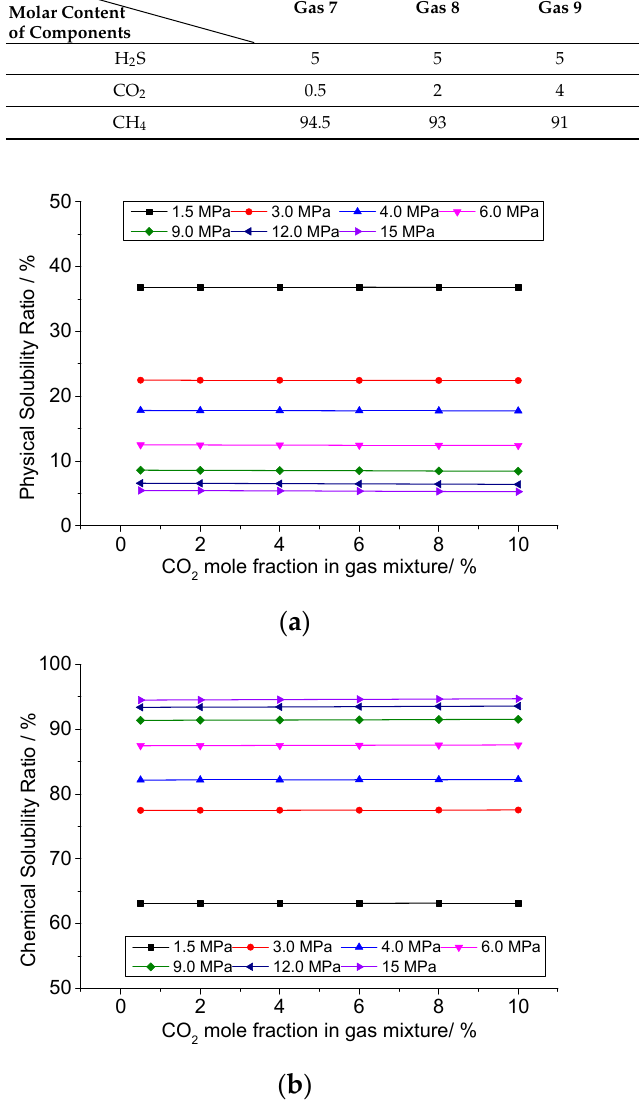
Figure 17. Percentage change curves of physical and chemical systems. ( a ) 293.15 K physical solubility; ( b ) 293.15 K chemical solubility.